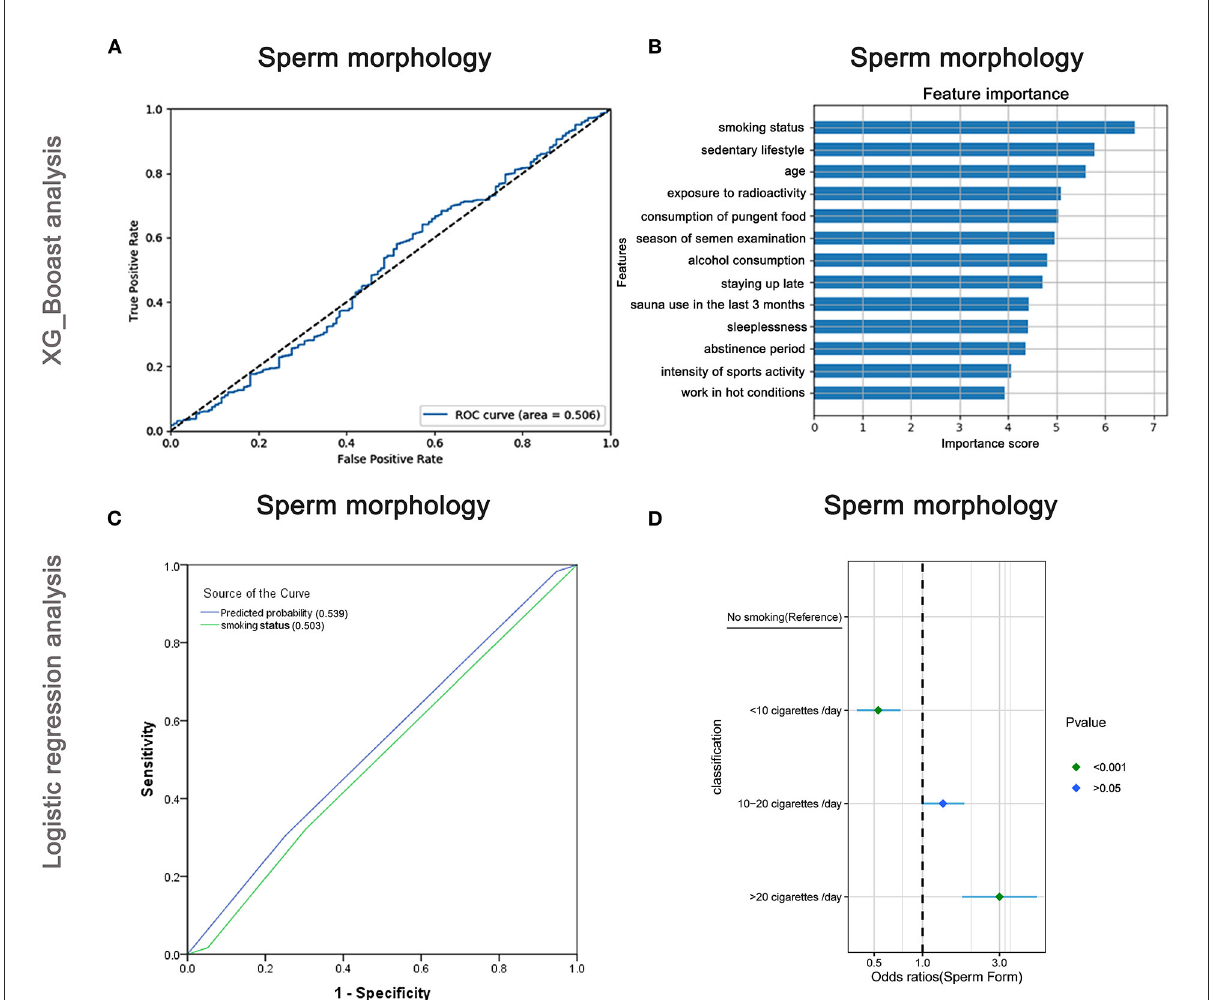
FIGURE7 XGBoost and logistic regression analysis of the risk factors for sperm morphology. The ROC curve (A) and feature importance (B) analyzed by XGBoost and the ROC curve (C) and forest diagram showing significant risk factors (D) analyzed by logistic